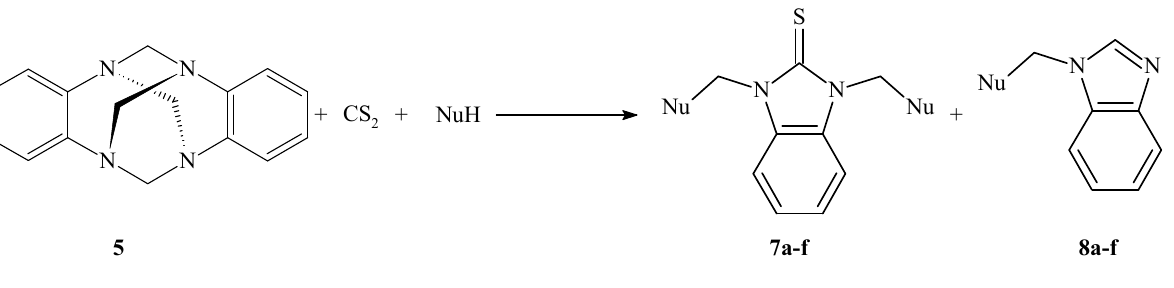
Scheme 1. General reaction of 5 with nucleophiles in the presence of CS